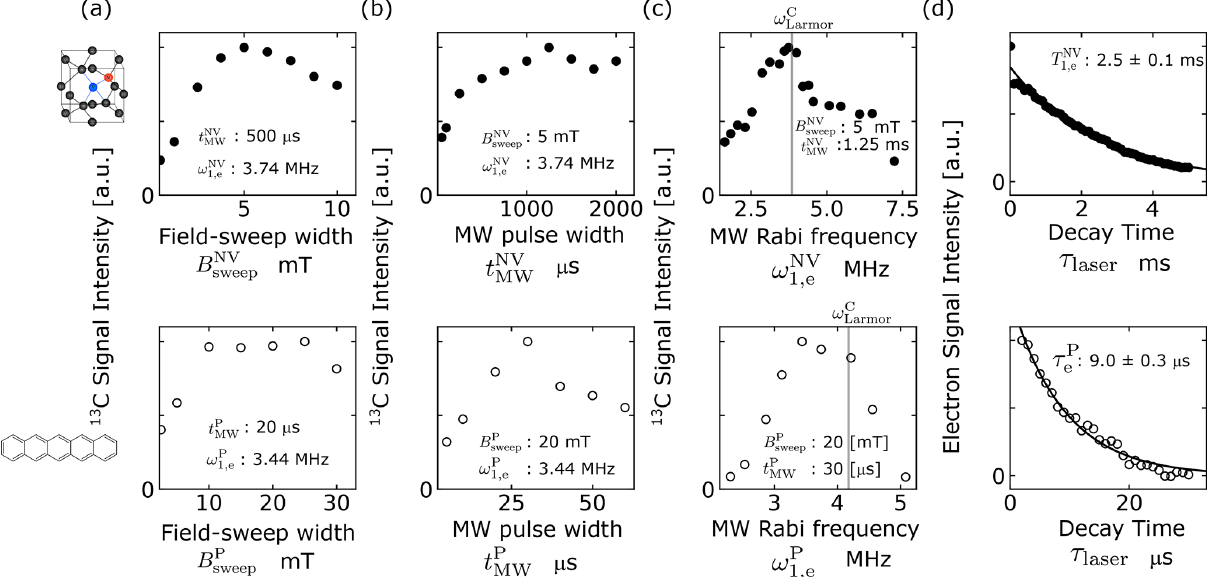
Figure 4. (a–c) Optimization of the ISE pulse sequence for microdiamonds (upper row, filled circles) and pentacene-doped benzoic acid (PBA) (lower row, open circles) through adjustment of (a) the field-sweep width B α sweep , (b) the microwave duration t α microwave intensity ω α , where α = NV , P for microdiamonds and PBA, respectively. The values of the fixed parameters are indicated in 1 , e each graph. The gray lines in (c) indicate the 13 C Larmor frequency for the magnetic field that corresponds to the low-field horn of the EPR spectrum. (d) Longitudinal relaxation (upper graph) and lifetime decay (lower graph) of the electron spins in the triplet state of NV − centers in microdiamonds and pentacene,